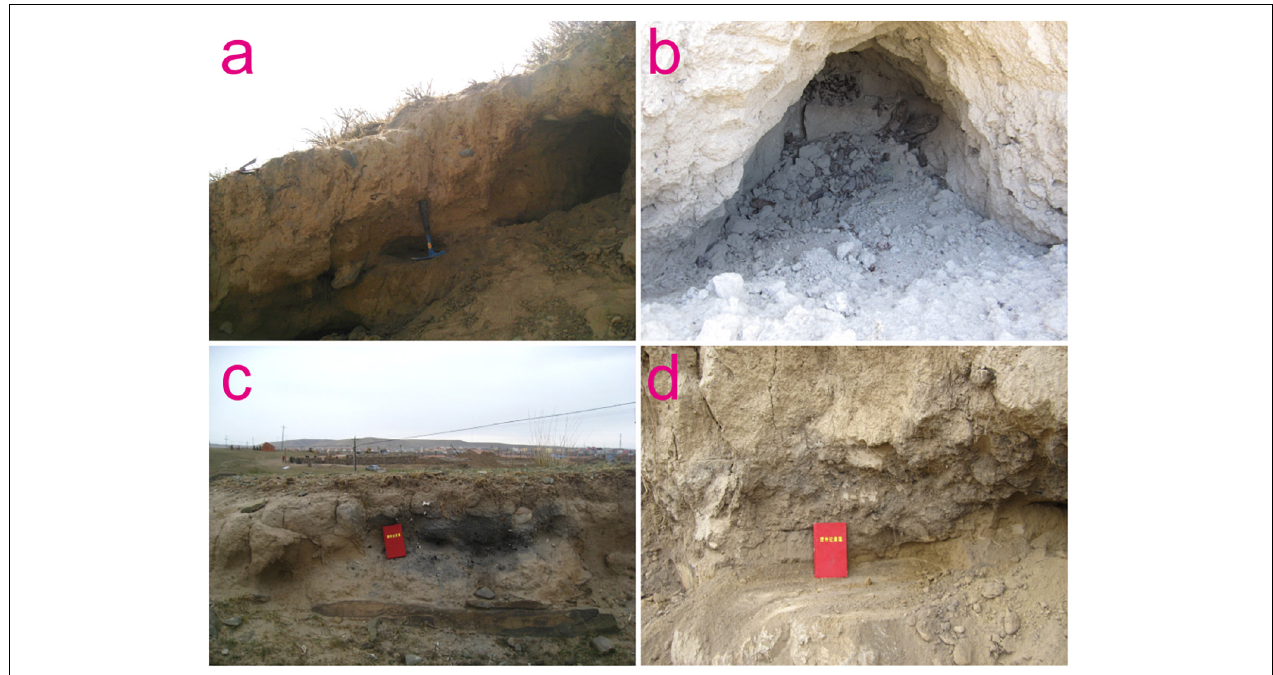
FIGURE 3 | Photographs of charcoal remains collected from some of the investigated sites in the NETP. (a) Luowalinchang; (b) Gayixiangjing; (c) Gongshijia; (d)